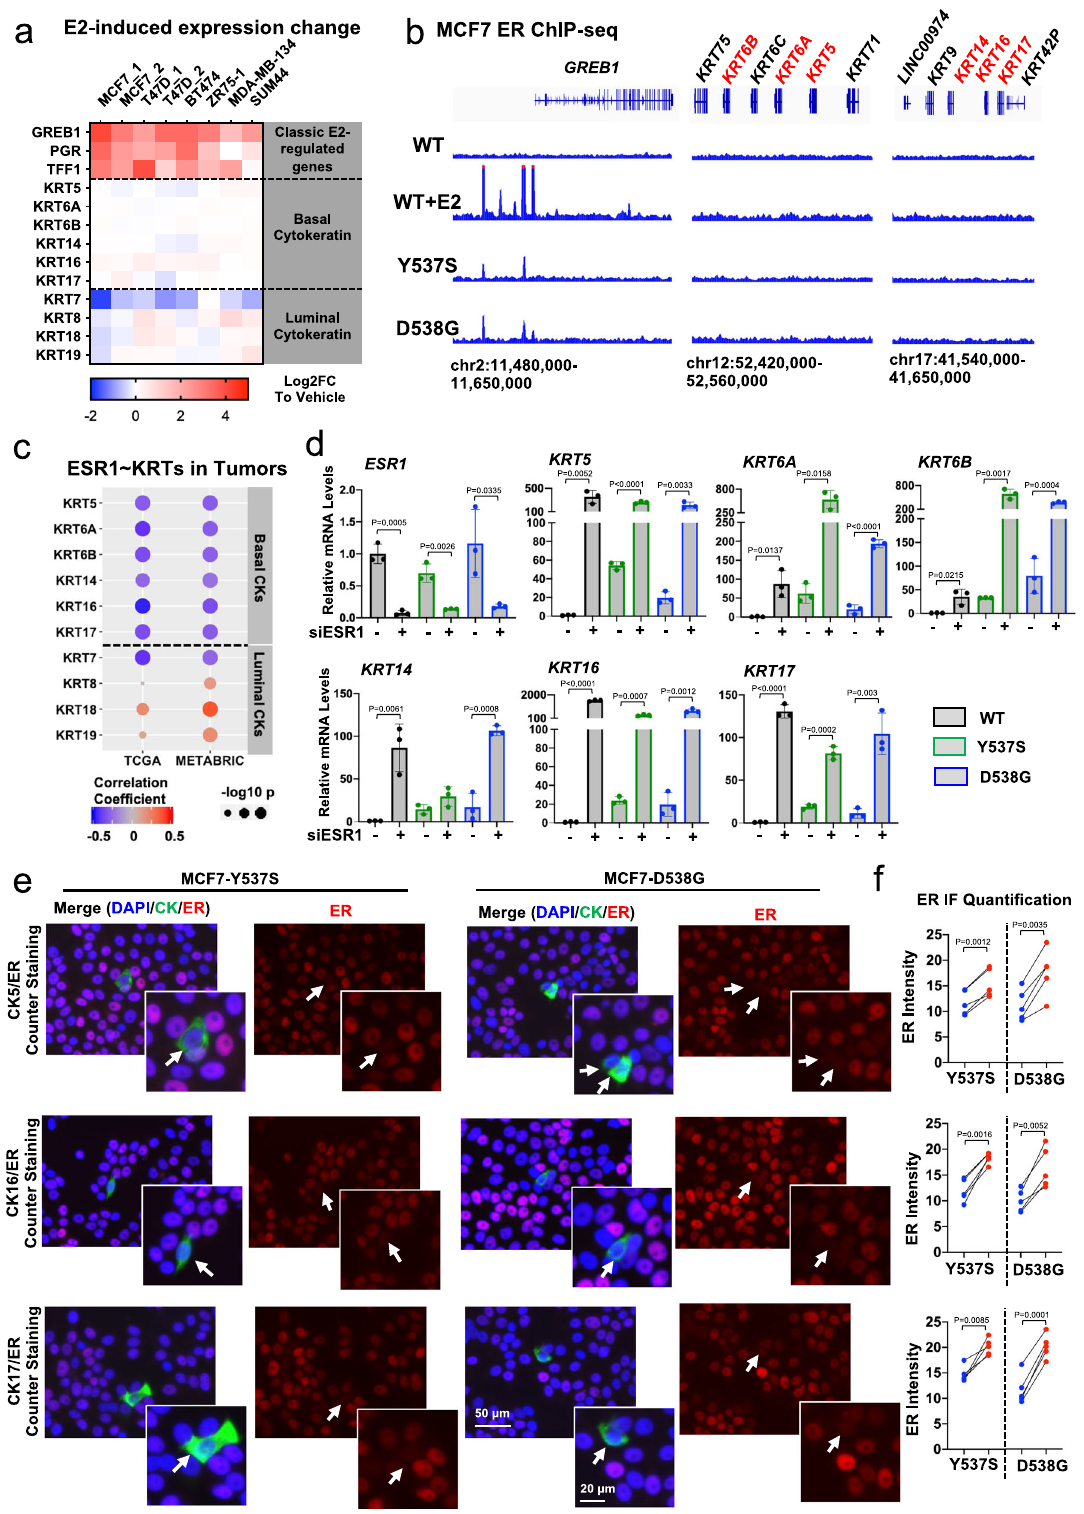
ChIP revealed strong enrichment of CTCF binding at the base of the chromatin loops of the KRT14/16/17 locus in ESR1 mutant cells, however there was a lack of E2 regulation (Fig. 4e). Decreasing CTCF levels led to increased expression of KRT14, KRT16 , and KRT17 mRNA levels in ESR1 mutant cells (Supple- mentary Fig. 10c), potentially re fl ecting a role for CTCF as “ classical ” insulator, suppressing high expression of these BCKs